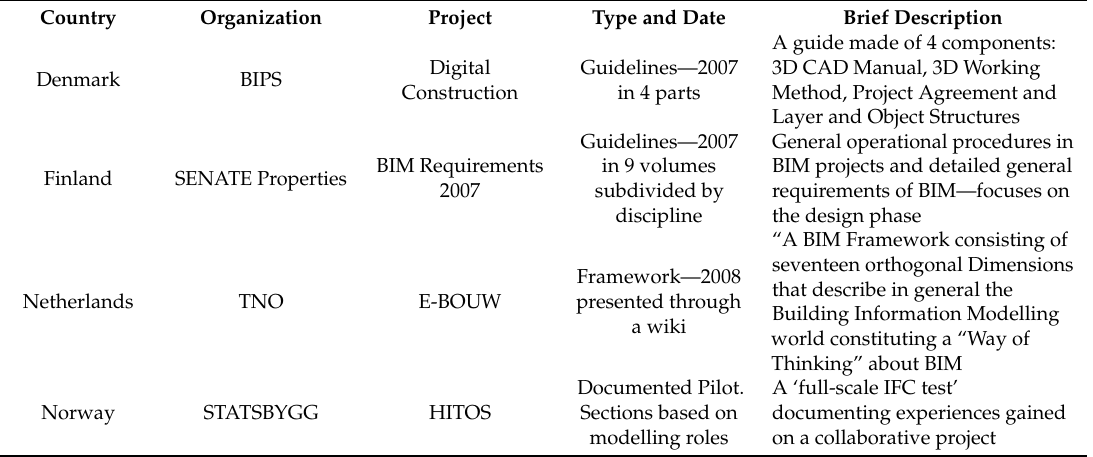
Table 1. An indicative list of publicly available guides and reports related to BIM. Source: